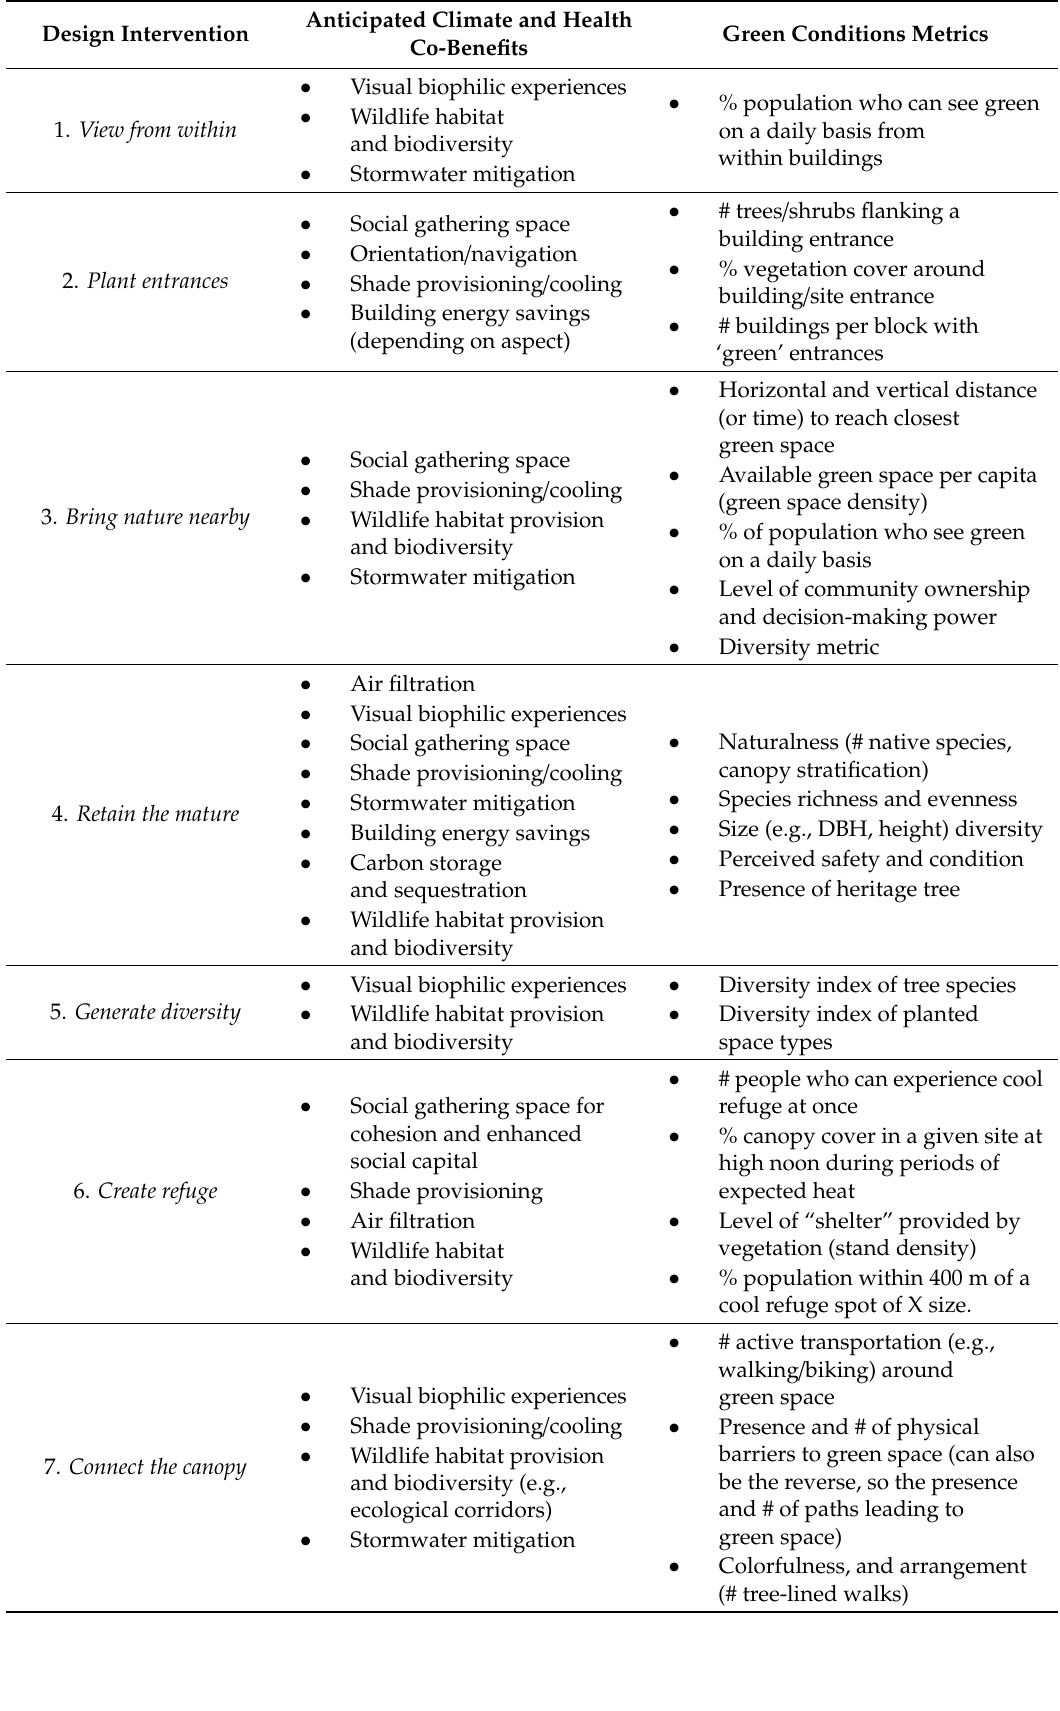
Table 1. Conceptual typology of practical green design interventions and their associated climate and health co-benefits and